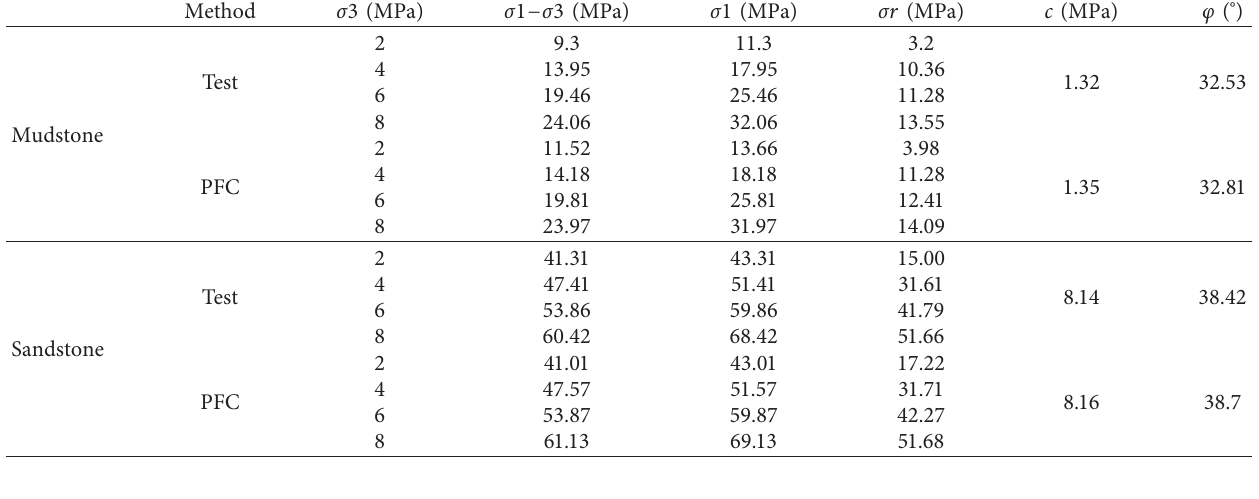
Table 1: Comparison of rock mechanics